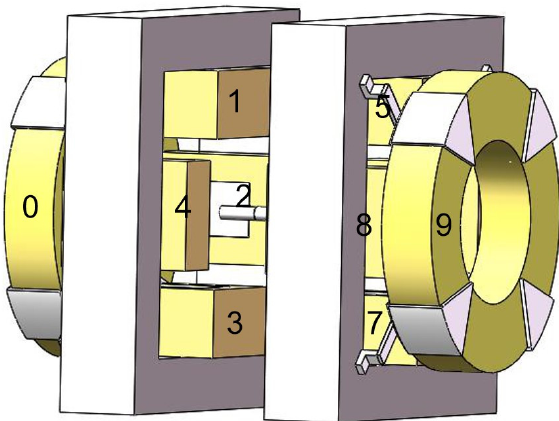
Figure 2. Structure diagram of magnetic suspension balance body.